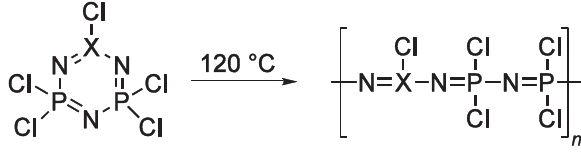
Figure 67. Examples of phosphazene analog monomers with increased ring strain (X = C,S).